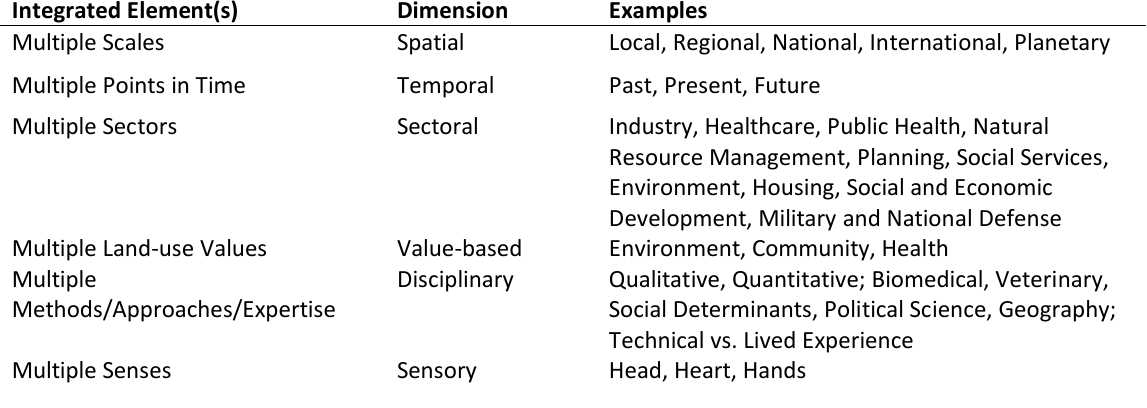
Table 4. Examples of Integrative Imperatives in Impact Assessment Integrated Element(s) Dimension